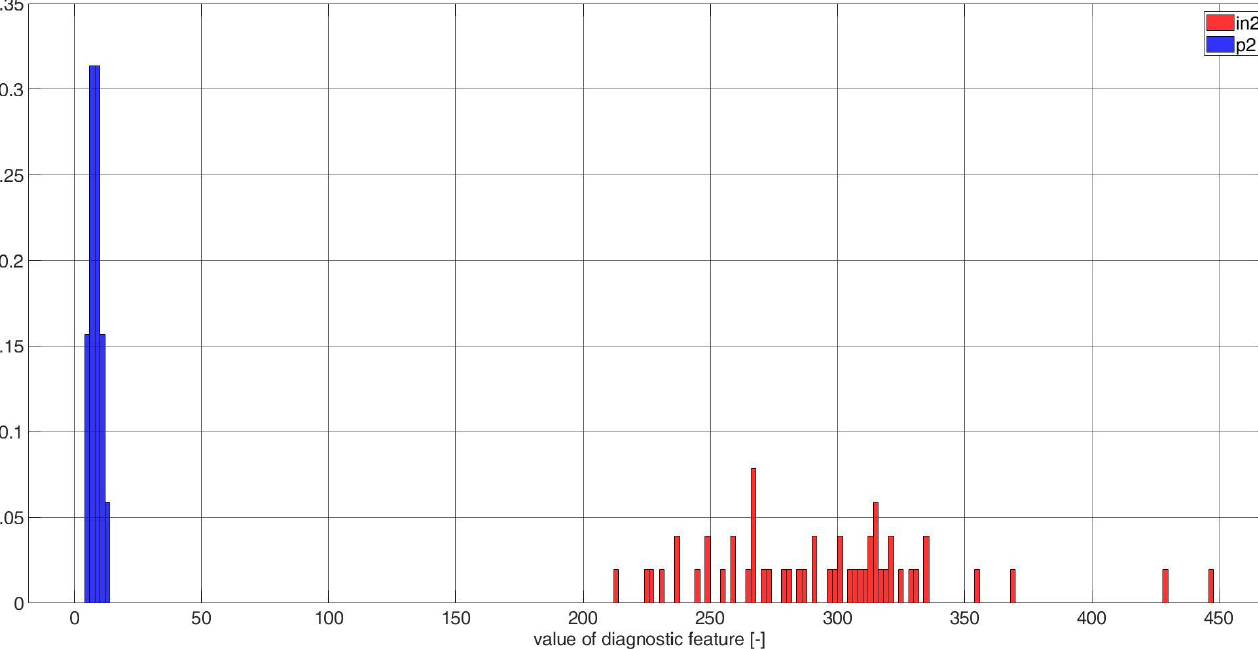
Figure A24. Histograms of diagnostic features based on the CCSM3 (correlation number is 24— Table A1) bearings in2 and p2.